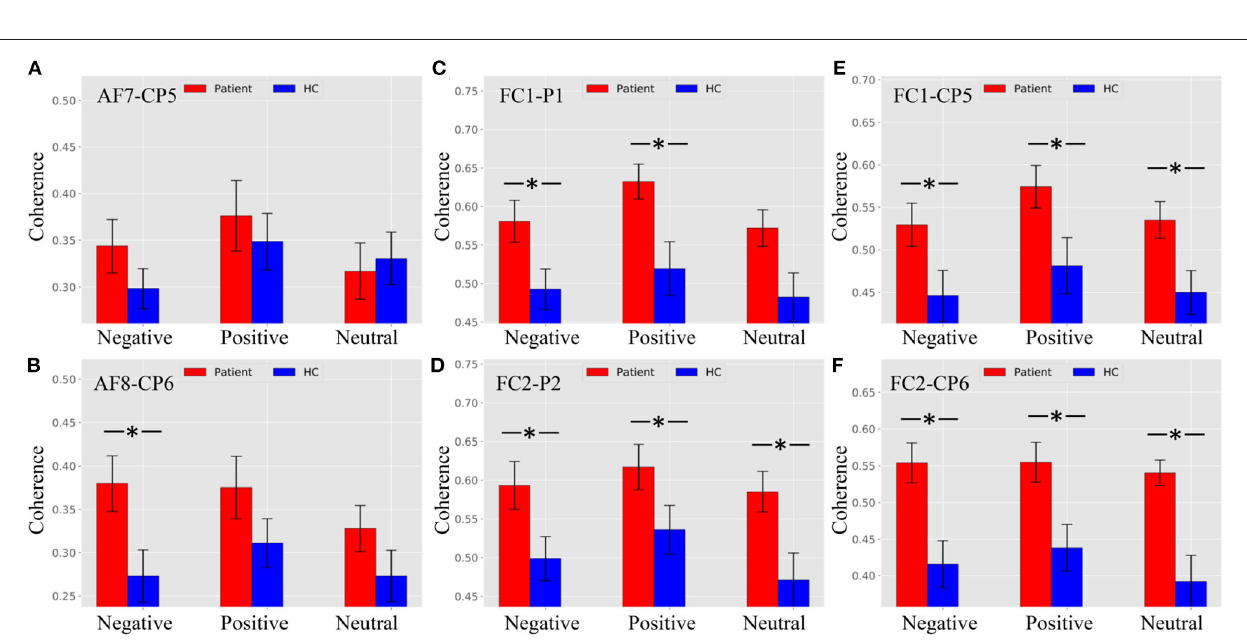
FIGURE 5 | Alpha ERPCoh between frontal and parietal electrode within 18096280ms. (A) Alpha ERPCoh between patients and HCs for all stimulus trials at the AF796CP5 electrode pair. (B) Alpha ERPCoh between patients and HCs for all stimulus trials at the AF896CP6 electrode pair. (C) Alpha ERPCoh between patients and HCs for all stimulus trials at the FC196P1 electrode pair. (D) Alpha ERPCoh between patients and HCs for all stimulus trials at the FC296P2 electrode pair. (E) Alpha ERPCoh between patients and HCs for all stimulus trials at the FC196CP5 electrode pair. (F) Alpha ERPCoh between patients and HCs for all stimulus trials at the FC296CP6 electrode pair. * p FDR − corrected ≤ 0.0367.